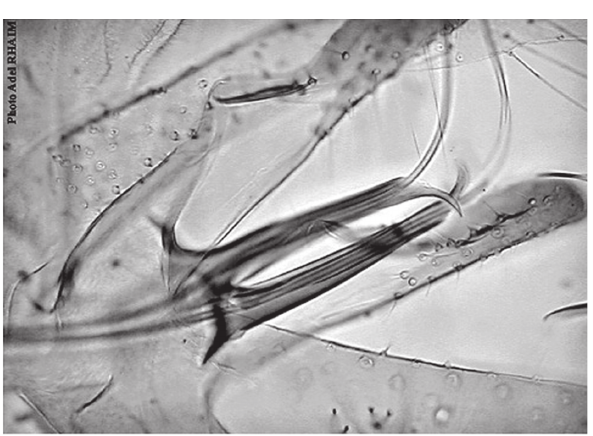
Fig. 4. – Aedeagi of P. perniciosus collected in south-eastern foci.